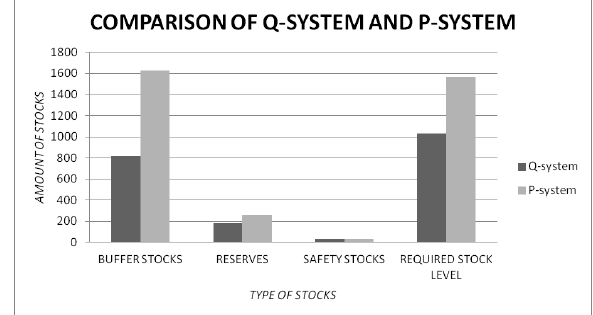
Figure 4: Comparison of the models